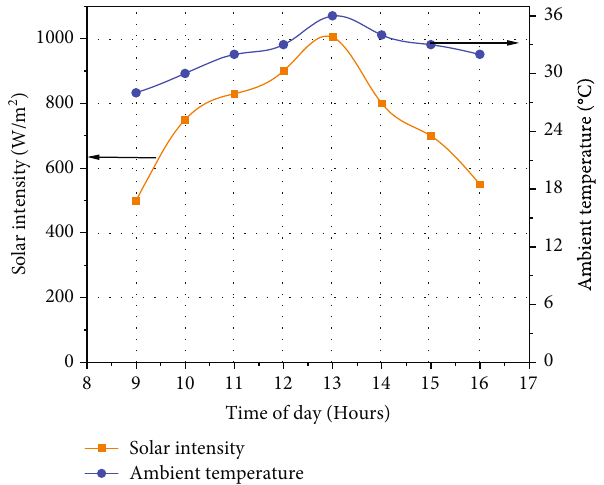
Figure 3: Time-wise fl uctuation of solar intensity and ambient temperature.